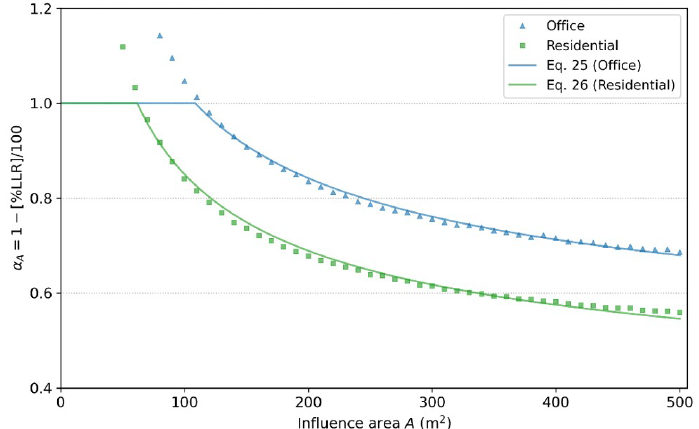
Figure 10. Example of proposed expressions for live load reduction based on influence